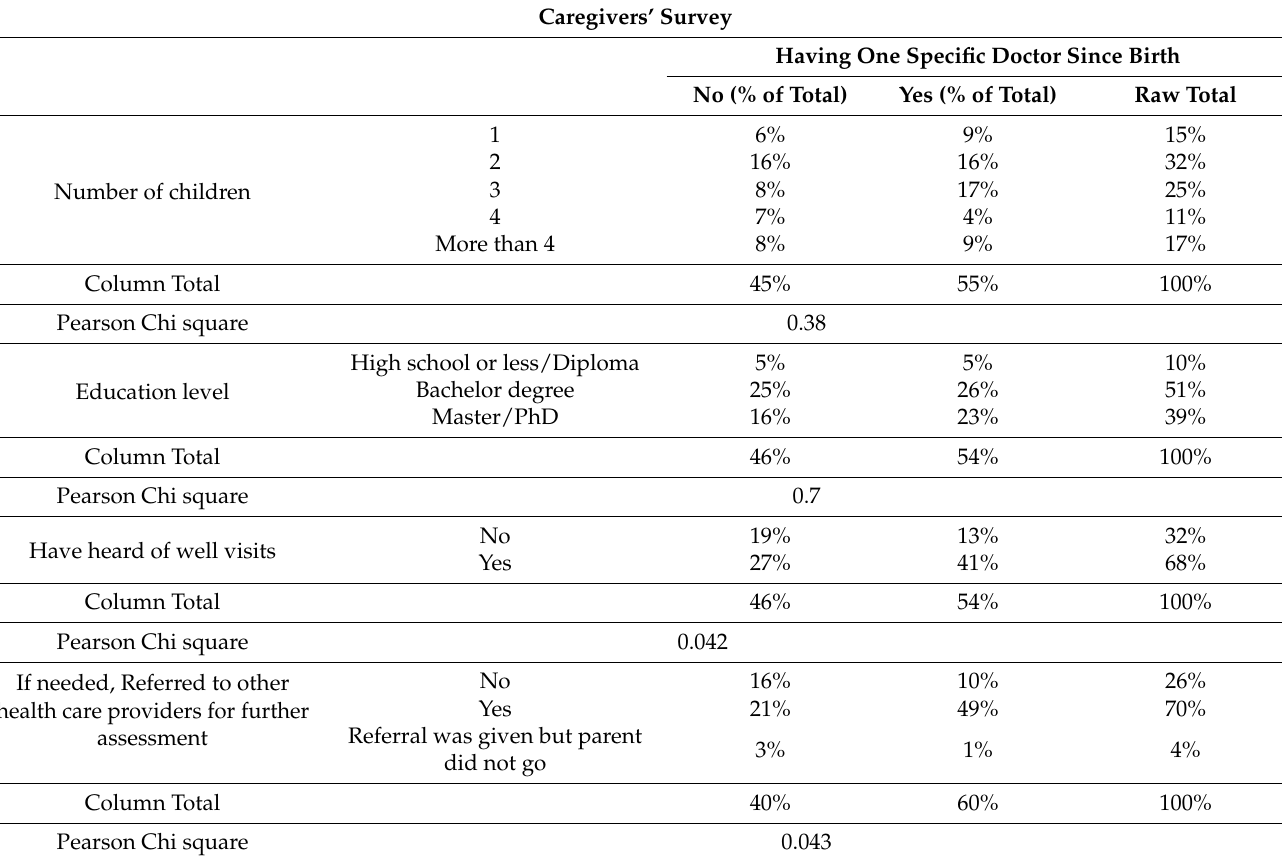
Table 4. Values for Having One Specific Doctor Since Birth by Number of Children, Caregiver’s Educational Level, Hearing About Well Visits, and